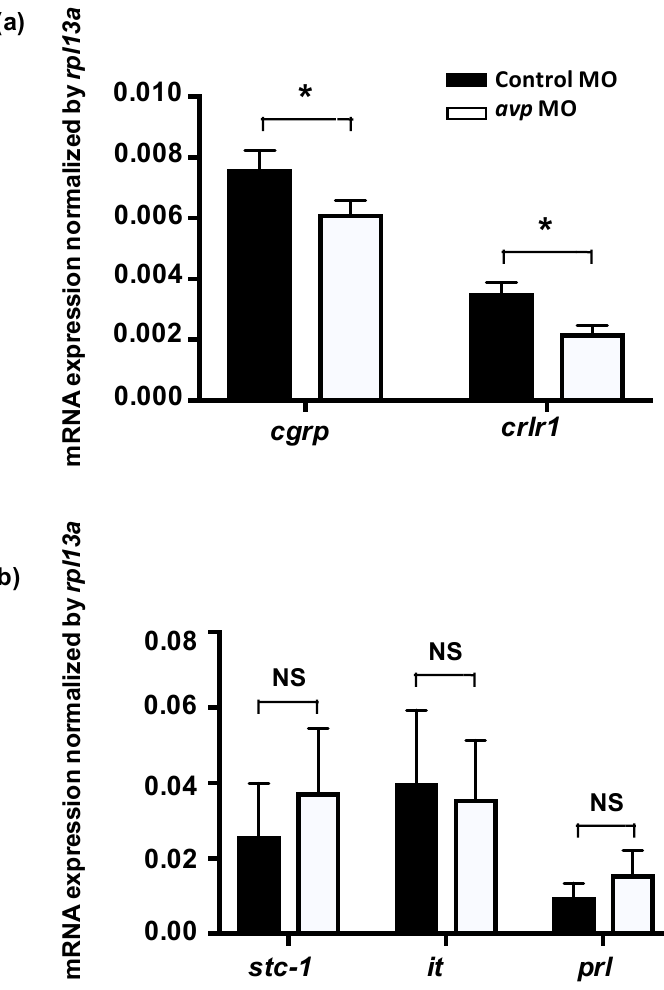
Figure 7. E ff ects of morpholino-mediated AVP downregulation on mRNA expression levels of hormone-related genes at 3 dpf, as measured by qRT-PCR. Relative expression levels of calcitonin gene-related peptide ( cgrp ) and its receptor ( crlr1 ) in fish injected with control morpholino (black bar) or antisense avp morpholino (white bar) are shown ( a ). Both genes exhibited significant di ff erences between control and avp morpholino-injected samples. Relative expression levels of hormone-related genes in fish injected with control morpholino (black bar) or antisense avp morpholino (white bar) are shown ( b ). The examined genes include stanniocalcin-1 ( stc-1 ), isotocin ( it ), and prolactin ( prl ). Values are mean ± s.e.m. ( n =